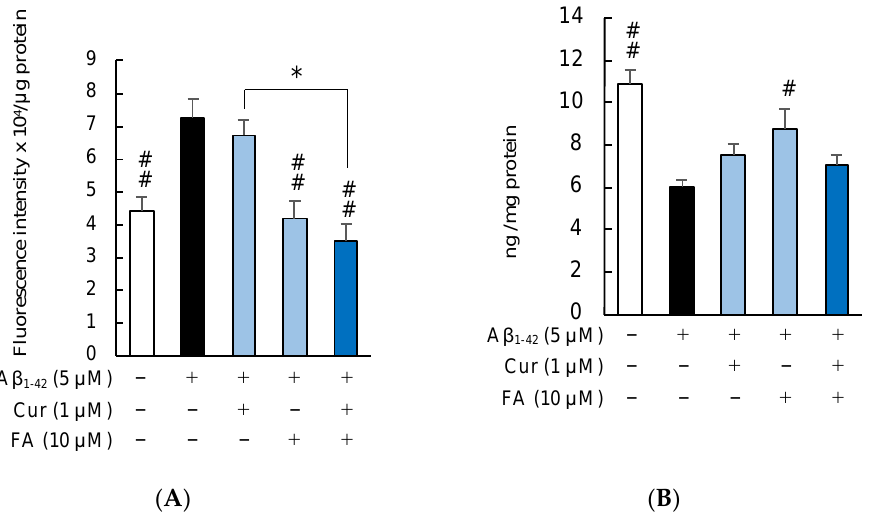
Figure 6. Effect of Cur, FA, or a combination of both on mitochondrial ROS and Mn- SOD in Aβ 1 – 42 - stimulated SH-SY5Y cells. Mitochondrial ROS levels were measured using a mitochondrial ROS detection reagent. Mn-SOD levels were measured using the Human SOD2 ELISA Kit. ( A ) The levels of mitochondrial ROS in SH-SY5Y cells exposed to 5 μM Aβ 1 – 42 and treated with Aβ 1 – 42 + 1 µM Cur, Aβ 1 – 42 + 10 µM FA or Aβ 1 – 42 + Cur + FA. In the absence of 5 μM Aβ 1 – 42 , mitochondrial ROS levels of control, 1 μM Cur, 10 μM FA and Cur + FA -treated cells were 4.26 ± 0.23, 4.38 ± 0.47, 4.52 ± 0.66 and 4.05 ± 0.42 x 10 4 /μg protein ( no significant difference, n = 6, Tukey). ( B ) The concentration of Mn- SOD in SH-SY5Y cells exposed to 5 µM Aβ 1 – 42 and treated with Aβ 1 – 42 + 1 µM Cur, Aβ 1 – 42 + 10 µM FA or Aβ 1 – 42 + Cur + FA. In the absence of 5 μM Aβ 1 – 42 , Mn- SOD levels of control, 1 μM Cur, 10 μM FA and Cur + FA-treated cells were 10.83 ± 0.79, 10.47 ± 1.21, 10.23 ± 1.14 and 10.20 ± 0.50 ng/mg protein (no significant difference, n = 6, Tukey). +: inclusion of 5 μ M A β 1 ̶̶ 42 , 1 μ M Cur, 10 μ M FA, respectively, − : non-inclusion. The p -values in ANOVA were <0.001. Each value expresses the mean + S.E.M. of at least 3 independent experiments. #, p < 0.05; ##, p < 0.01 for Aβ 1 – 42 exposed cells versus the other treated cells (n = 6, Tukey): *, p <0.01 for Aβ 1 – 42 + Cur + FA-treated cells versus Cur- treated cells (n = 6, Tukey).